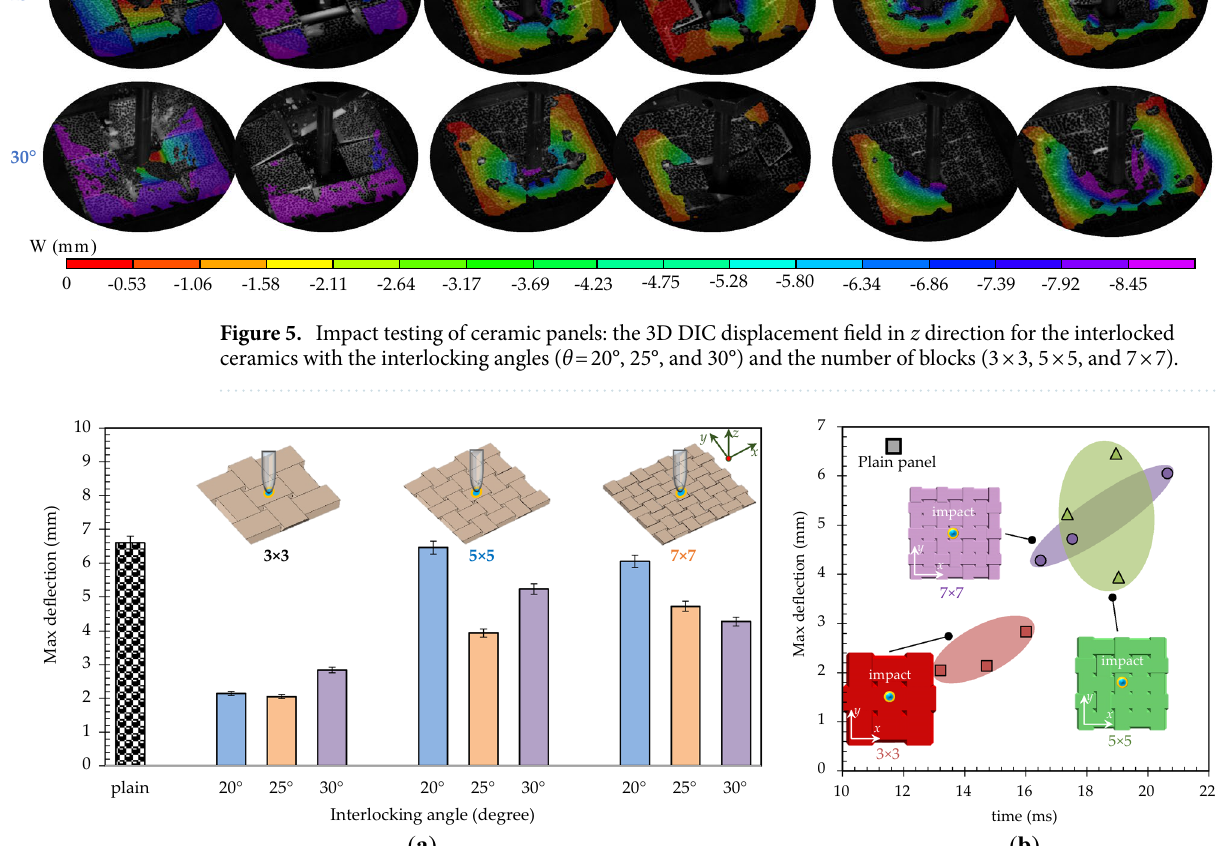
Figure 6. The properties of the architectured and plain ceramics: ( a ) maximum deformation, and ( b ) maximum deformation versus time at maximum deformation of the panels as functions of interlocking angle ( θ = 20°, 25°, and 30°) and number of blocks (3 × 3, 5 × 5, and 7 × Figure 6a,b present the maximum deformation and maximum deformation versus time when the maximum deformation occurs for the architectured and plain ceramic as functions of the interlocking angle ( θ = 20°, 25°, and 30°) and the number of blocks (3 × 3, 5 × 5, and 7 × 7). The observed differences are translated into variations in stiffness, strength and energy absorption. The plain panel deforms the same as much as the 5 × 5-block panel with θ = 20° does. Generally, the panels with a smaller interlocking angle showed a higher maximum deformation except for the 3 × 3- block panel. It is seen from Fig. 6b that the 5 × 5- and 7 × 7- block panels took more time to reach to their maximum deflections compared to the 3 × 3- block panel. The 5 × 5- and 7 × 7- block panels also show a higher maximum deflection (see Fig. 6a). The strengths of the architectured ceramics are expected to notably be less than that of the plain panel due to frictional interfaces in the material system. However, this is advantageous for flexible protection such as in personal protective equipment. The improvement in energy absorption provides the ceramic system with multi-hit resistant. Importantly, the architectured ceramics can have less of the response load transferred to the system, which is another advantage for armor and shielding applications. The stiffness of the panels is expected to increase with the interlocking angle because of increased mechanical interaction between the blocks.